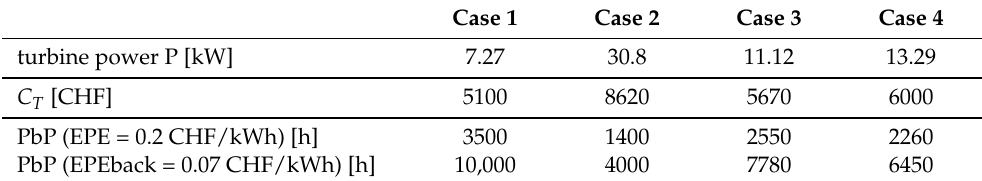
Table 3. PbP for the four cases studied in detail, EPE = 0.2 CHF/kWh, EPEback = 0.07